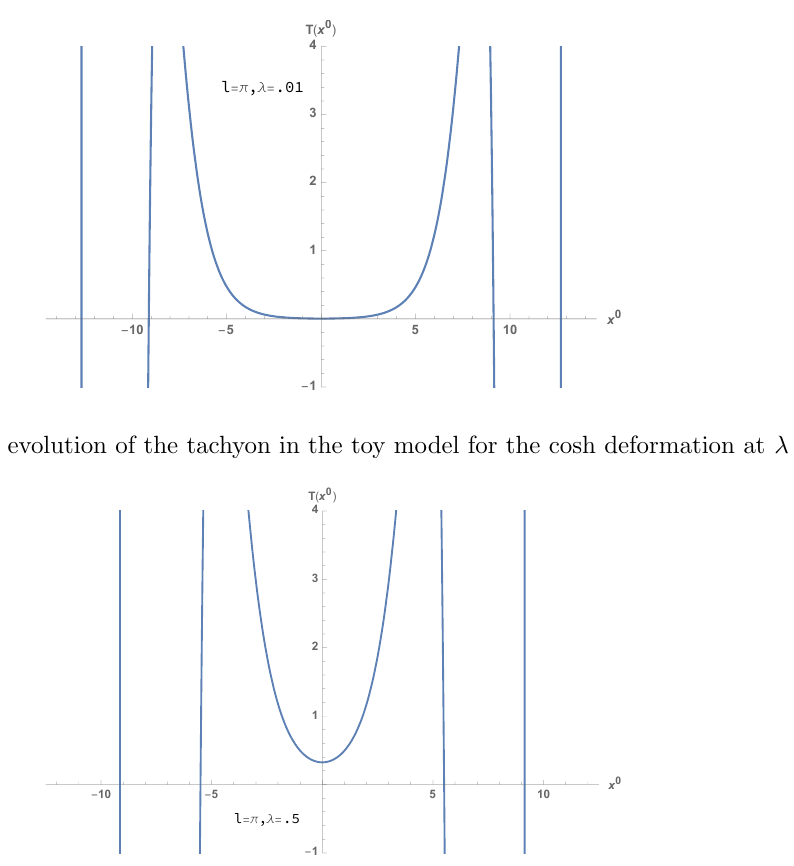
Figure 23 . Time evolution of the tachyon in the toy model at the critical value (cid:21) = 1 = 2 of the cosh